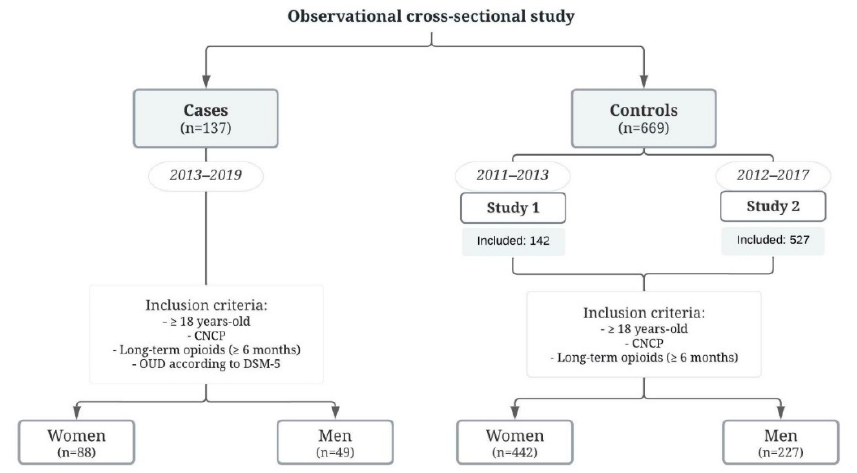
Figure 1. Flow chart of the patient selection for the study. CNCP, chronic non-cancer pain; OUD, opioid use disorder.